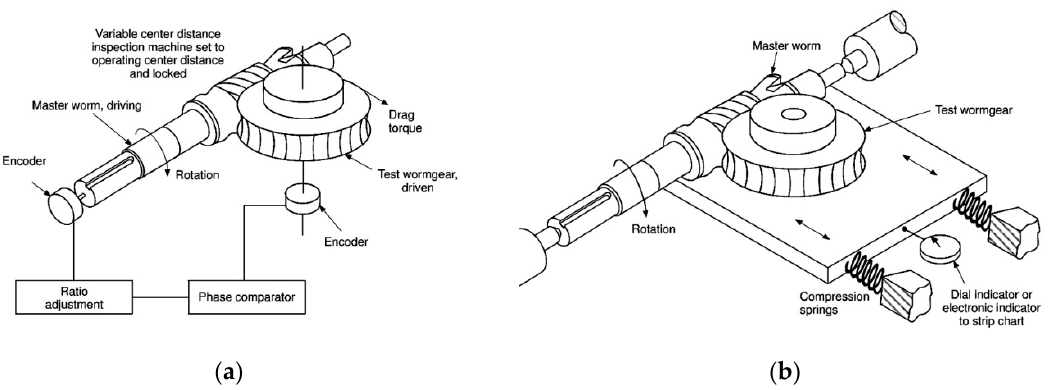
Figure 1. Worm gear rolling tests working principle: ( a ) single flank rolling test; ( b ) double flank rolling test. (Reprinted from [10] with permission of the copyright holder, AGMA).